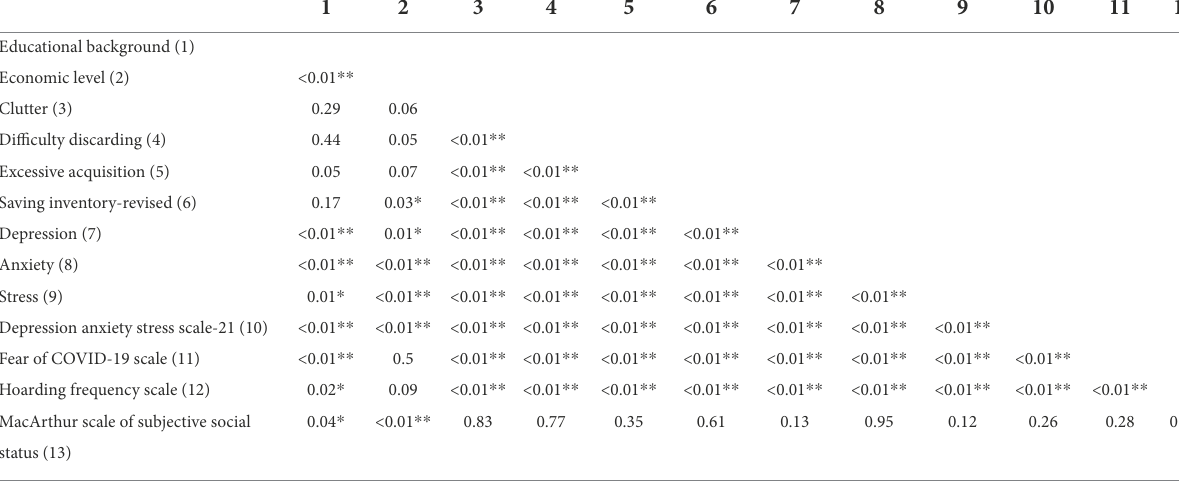
TABLE 2 Summary of the analysis of correlations among the scales ( r